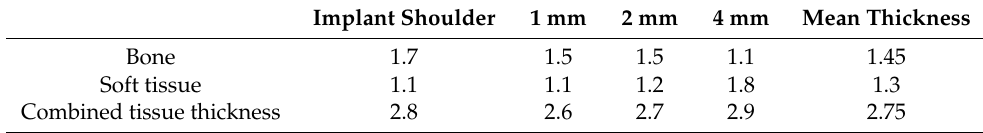
Table 2. Facial bone and soft tissue thickness (in mm) around implant at T5 time